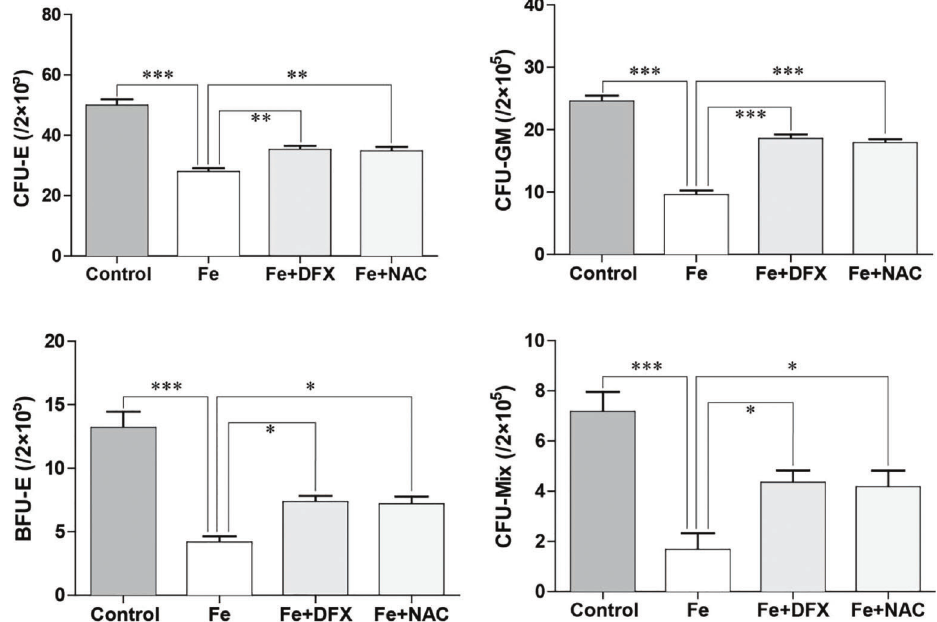
Figure 5. Results of colony-forming unit erythroid (CFU-E), granulocyte-macrophage (CFU-GM), burst-forming unit erythroid (BFU-E), and colony-forming unit mix (CFU-Mix) assays of bone marrow of iron overload (Fe) mice and after the administration of deferasirox (DFX) or N-acetyl-L-cysteine (NAC). Data are reported as means ± SD. *P o 0.05, **P o 0.01, and ***P o 0.001 (ANOVA).